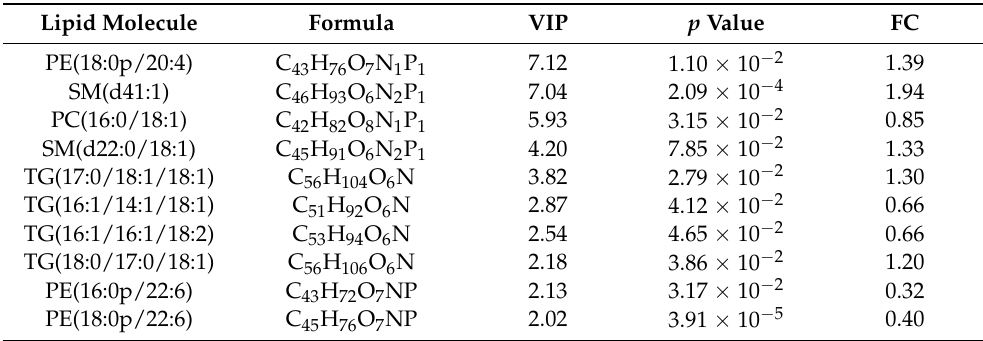
Table 2. The information for different lipids (DLs) in the subcutaneous fat of yaks under different feeding